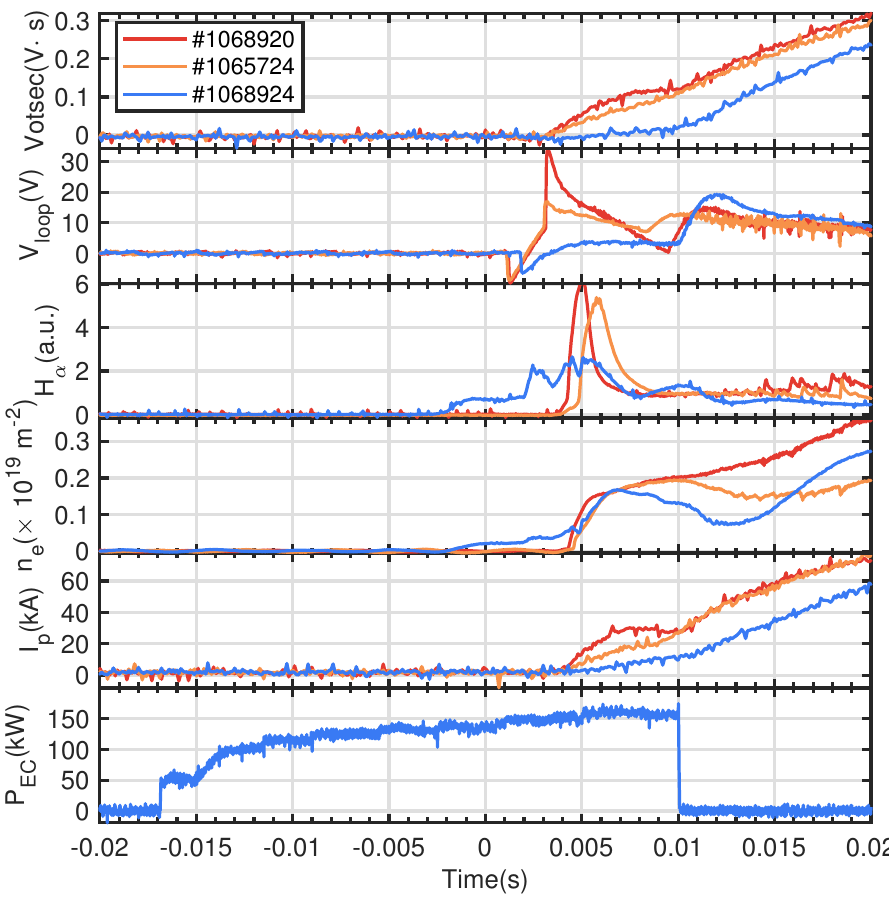
Figure 4. Evolution of di ff erent signals when discharging with ionization capacitor of 1600 V (red, #1068920), 800 V (orange, #1065724) and 1V (blue, #1068924). The last one is assisted with 300 kW ECH power while the two others are purely Ohmic heating. All the experimental densities presented in this paper are line-integrated